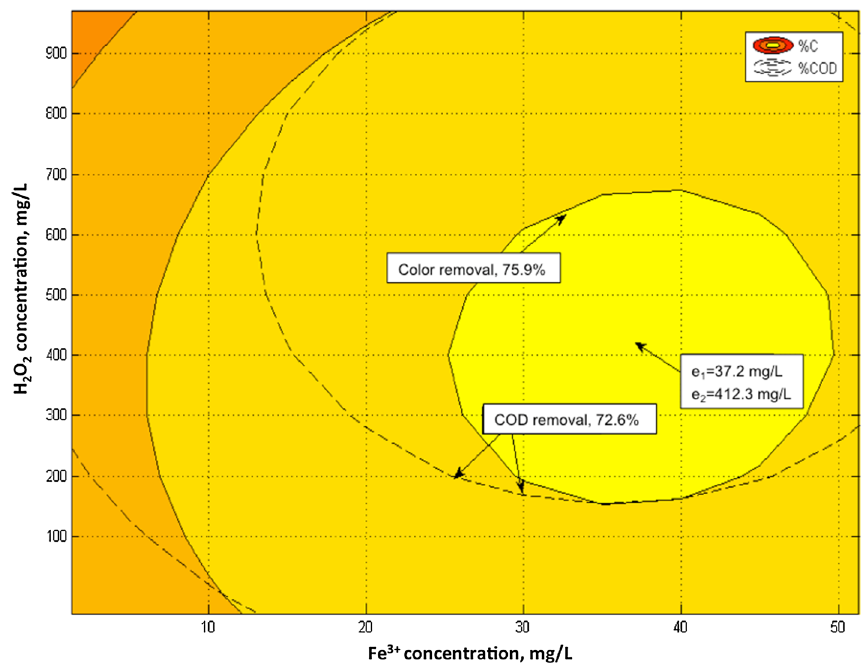
Fig. 5 Overlay contour plots for photo-Fenton optimal region of two responses